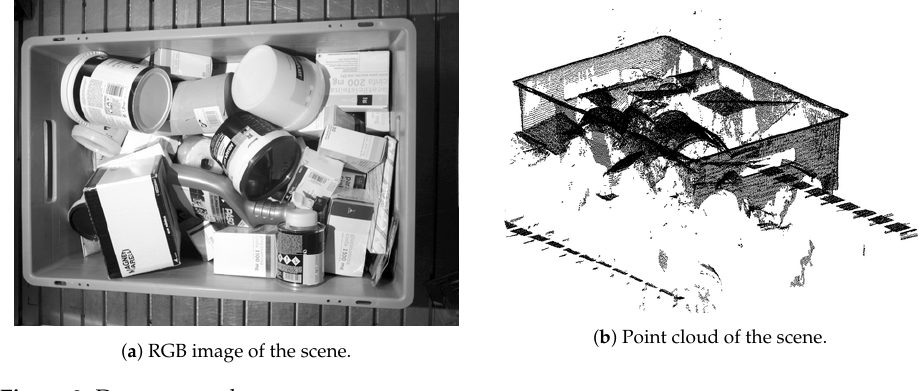
Figure 3. Dataset sample